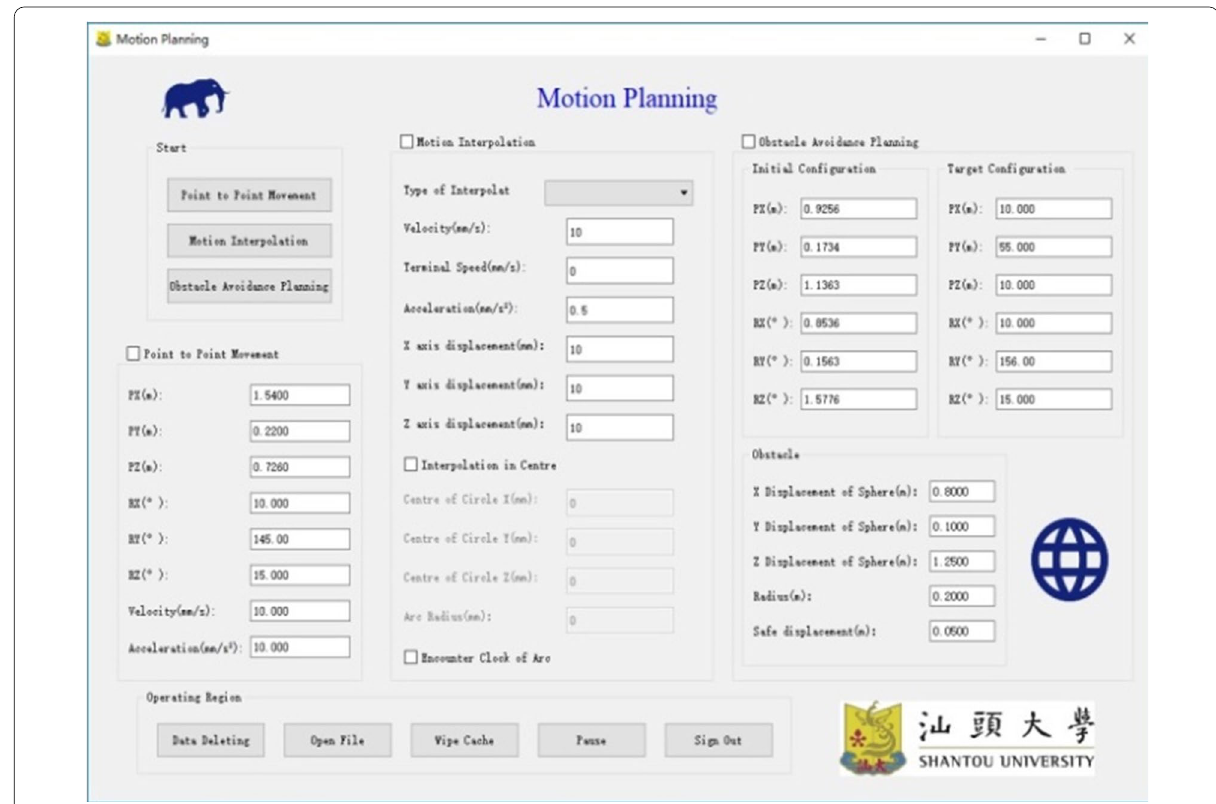
Figure 17 Interface of motion planning for HRETR